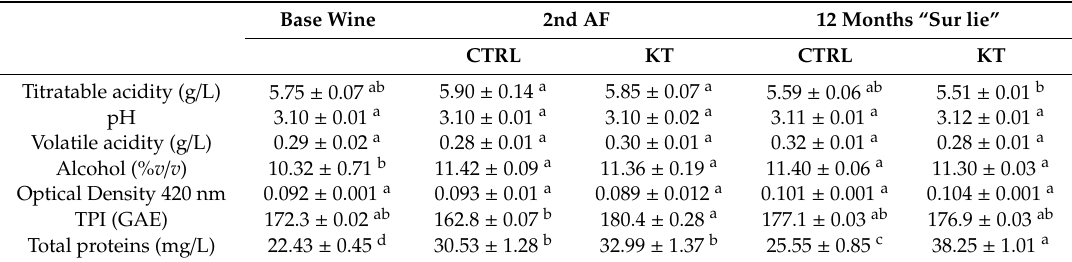
Table 1. Oenological parameters and total protein concentration of the samples after secondary alcoholic fermentation (2nd AF) and after 12 months of ageing “sur lie.” In the same row, di ff erent letters indicate significant di ff erences according to Tukey’s test ( p < 0.05). n = 3. TPI = total phenolics; GAE = gallic acid equivalent.